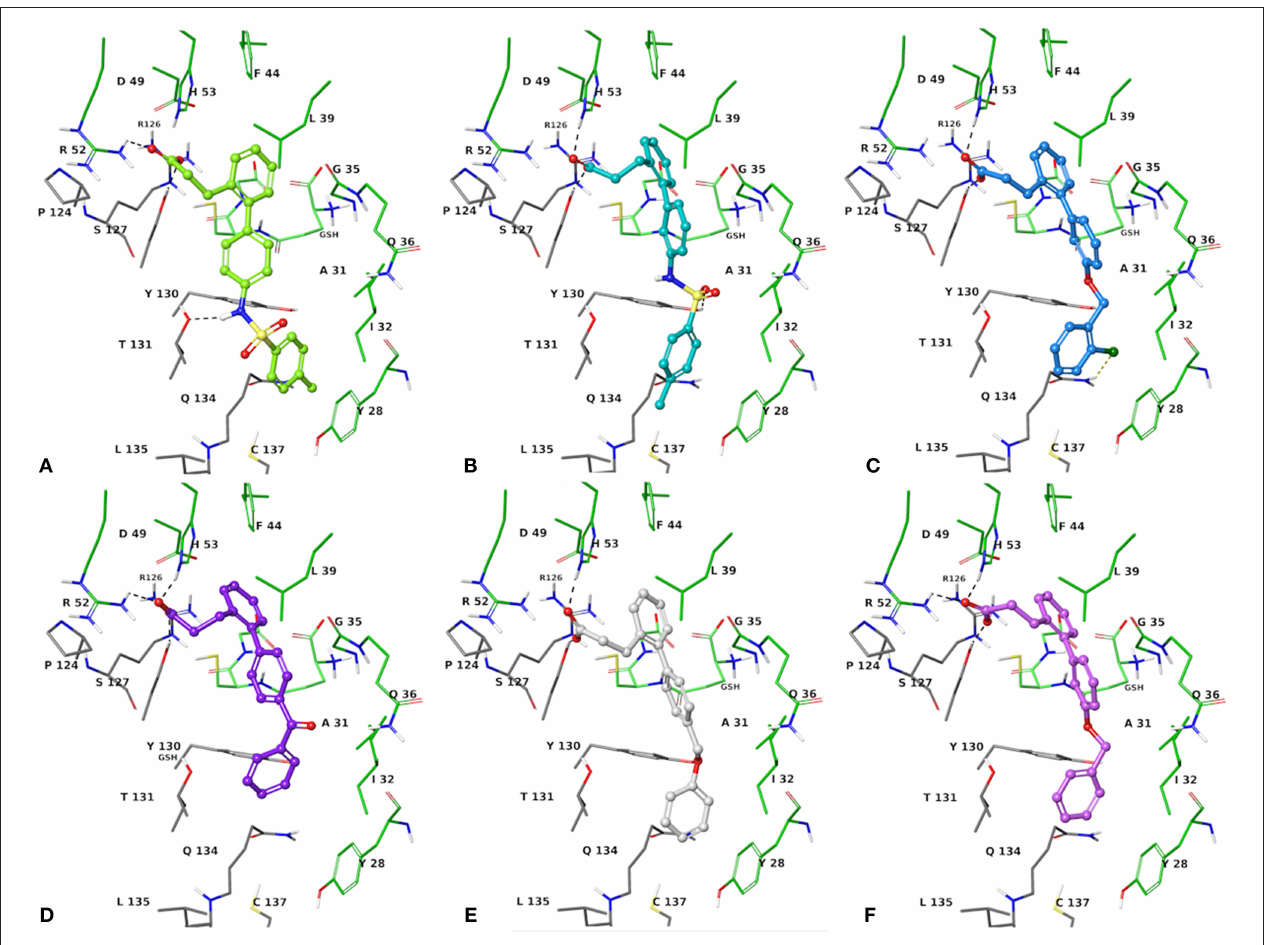
FIGURE 4 | Three-dimensional model of the interactions given by 1a (A) , 1b (B) , 1c (C) , 1d (D) , 1e (E) , and 1f (F) with mPGES-1. The protein is depicted by tube [colored: C, gray (chain A) and green (chain B); polar H, white; N, dark-blue; O, red; S, yellow]. The GSH is sketched in the faded green tube. The small molecules are represented by sticks (yellow-green for 1a , teal for 1b , azure for 1c , violet for 1d , platinum for 1e , faded plum for 1f ) and balls (colored: C, as for the sticks; polar H, white; N, dark-blue; O, red). The dashed black and yellow lines indicate the hydrogen and halogen bonds, respectively, between ligand and